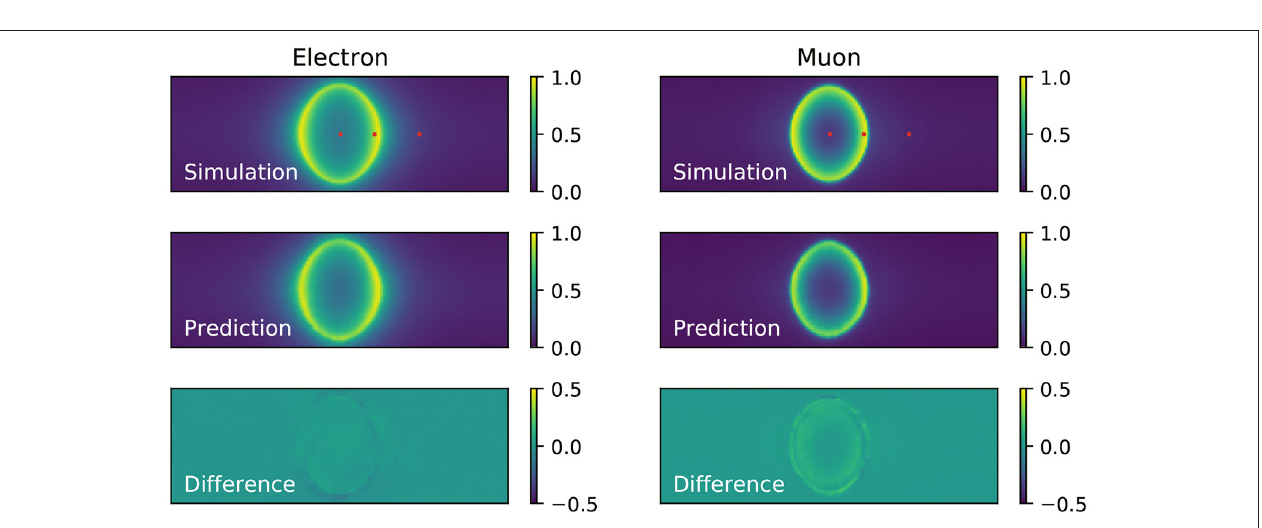
FIGURE 4 | Comparison of the hit probability for simulated (top) electron (left) and muon (right) events generated with fixed kinematics, and the neural network prediction (middle) . The difference between the neural network prediction and the simulation is shown in the bottom. These results were produced with the single-component charge-only loss function. The red marks on the top panel figure indicate the location of the three reference PMTs chosen to examine the hit charge and time